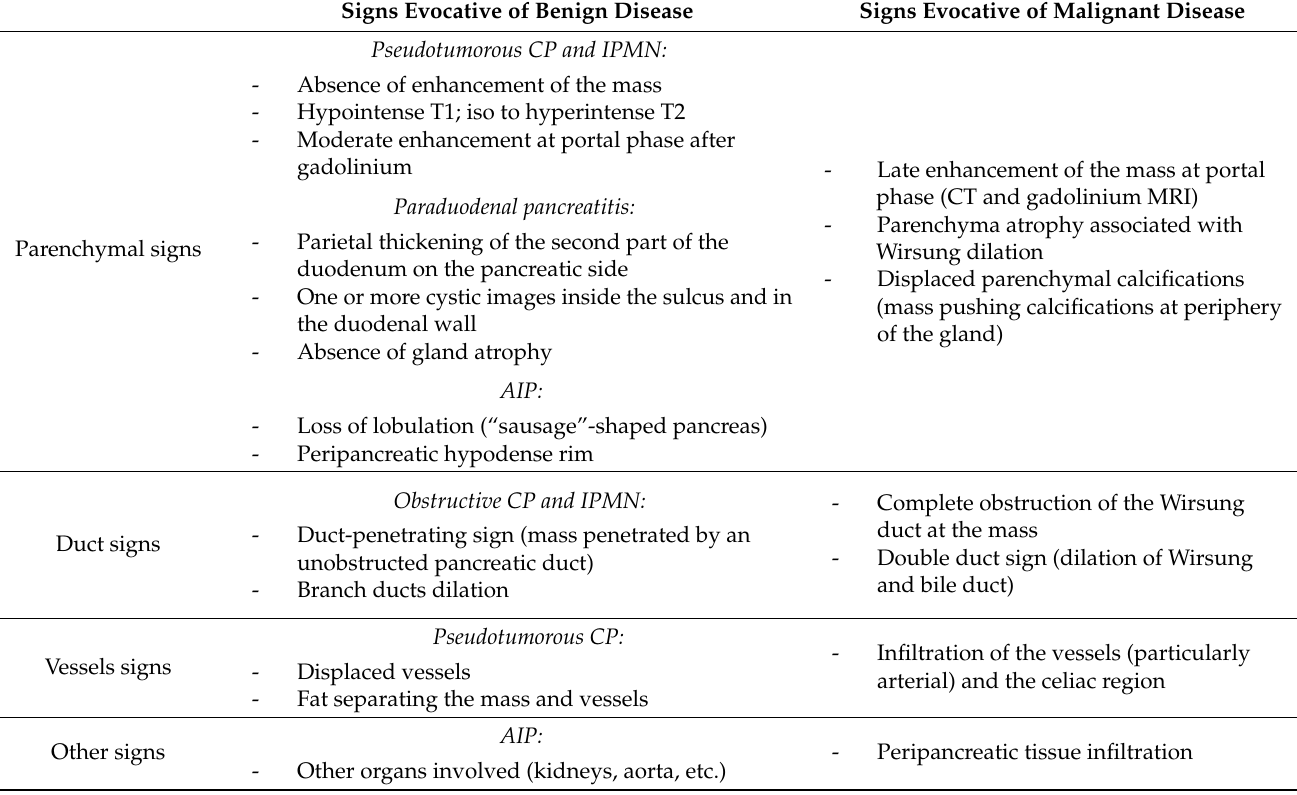
Table 3. Predictive value of radiological signs. Signs Evocative of Benign Disease Signs Evocative of Malignant